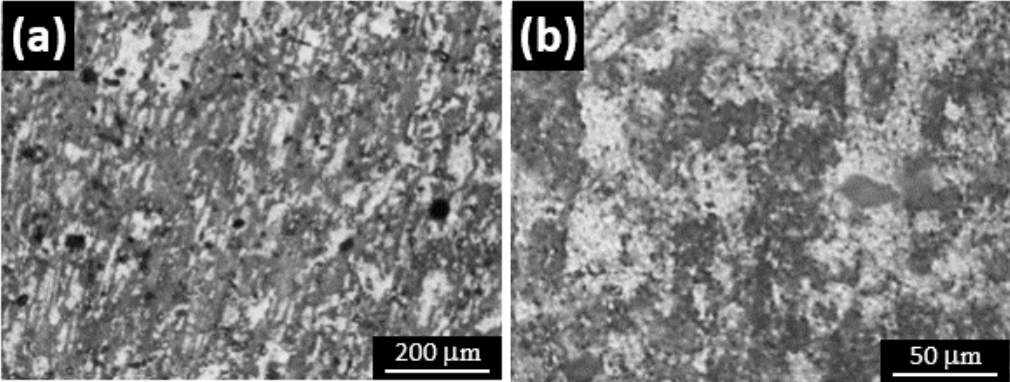
Figure 6. Microstructural features of 2205 duplex stainless-steel at different magnifications: ( a ) 200 µm scale bar and ( b ) 50 µm scale bar.